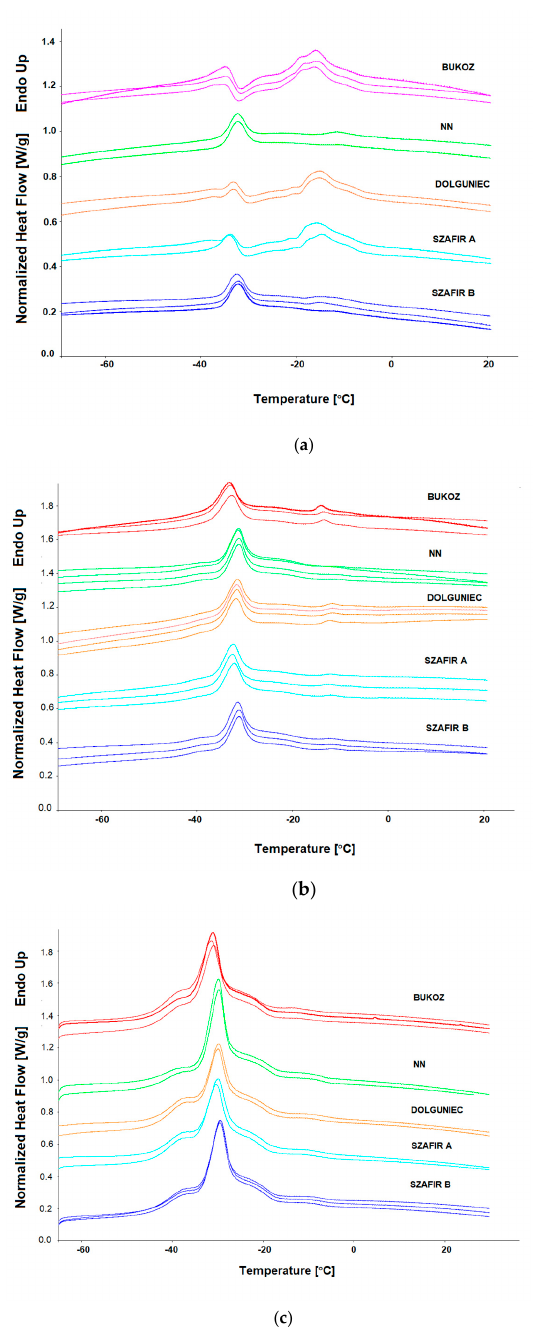
Figure 2. DSC melting curves of cold-pressed flaxseed oils from different cultivars obtained with various heating rates: ( a ) Heating rate 1 ◦ C/min; ( b ) Heating rate 2 ◦ C/min; ( c ) Heating rate 5 ◦